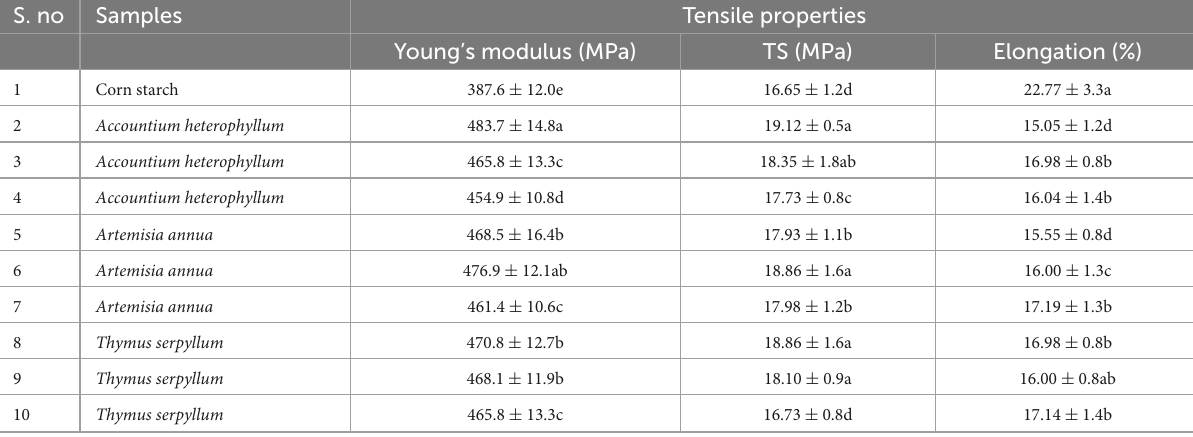
TABLE 4 Effect of starch-based films reinforced with different medicinal plants and tensile properties of films.